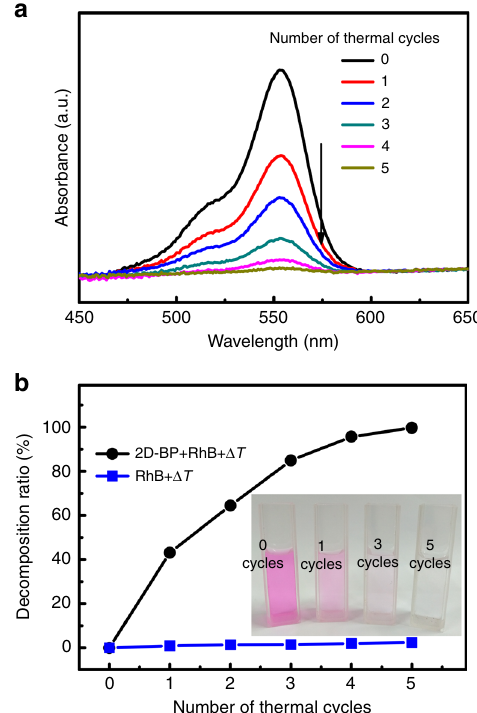
Fig. 6 Pyro-catalysis of 2D-BP for dye decomposition. a The pyro-catalytic variation of the absorption spectra of RhB dye solution (5 mg L − 1 ) with different thermal cycles between 15 and 65 °C. b The decomposition ratio as a function of thermal cycles. The inset shows the photos of the pyro-catalytically-decomposed RhB dye solution of 2D few-layer black phosphorene (2D-BP) at different